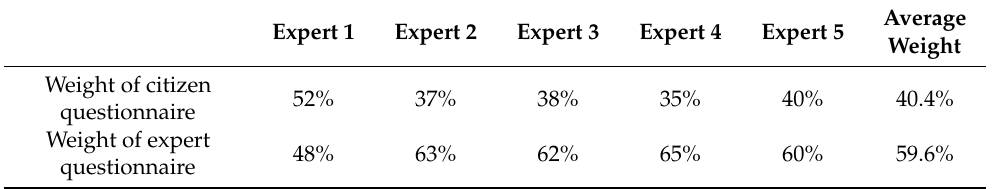
Table 13. Weight of the citizen and expert